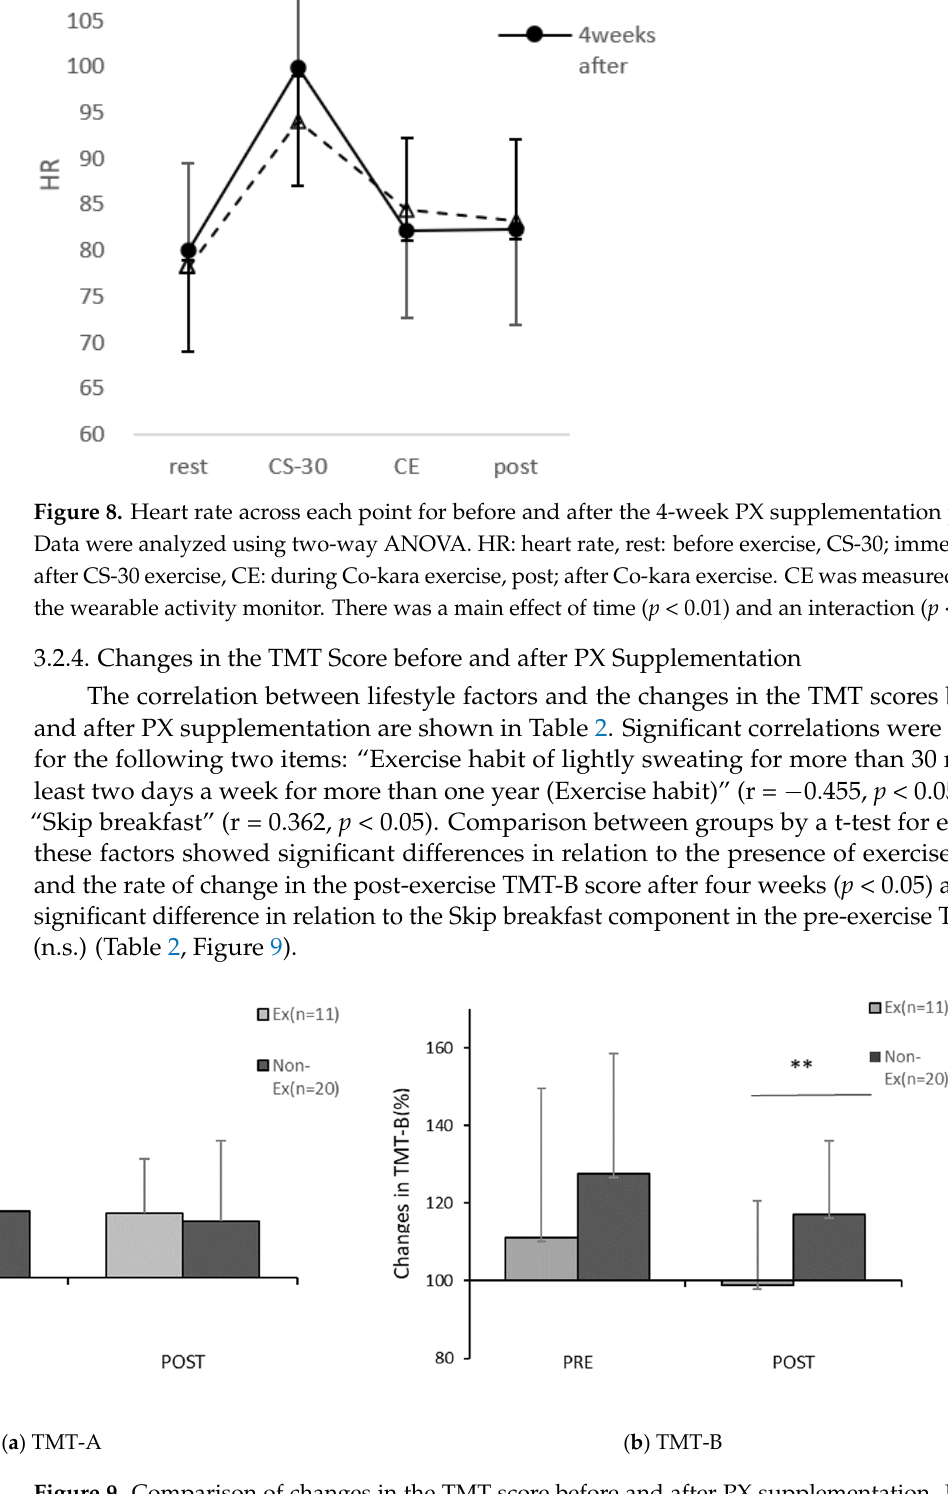
Figure 7. Comparisons of each trial in CS-30 before and after the 4-week PX supplementation period; before: the first session; 4 weeks after: after the 4-week PX supplementation period. ( n = 31); before vs. 4 weeks after: ††† p < 0.001 ( p = 0.000, d = 0.73).